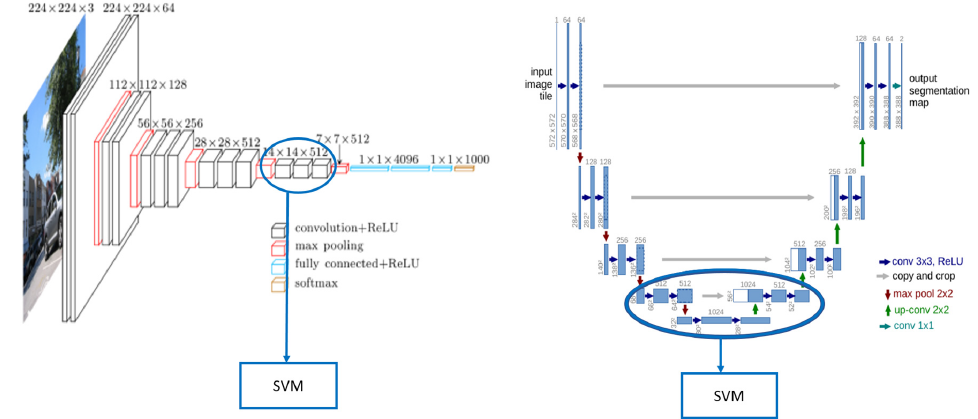
Figure 5. Adaptation of models for transfer learning, VGGNet on the left, UNet on the